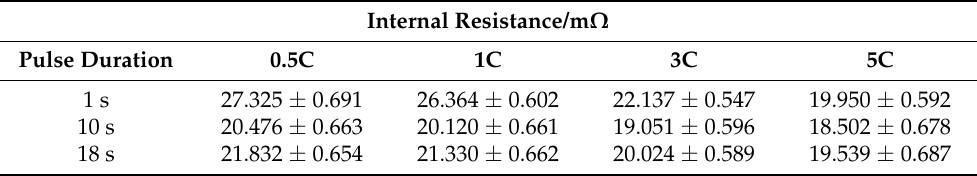
Table 5. Internal resistances at different current rates and pulse durations at a SoC level of 50%.